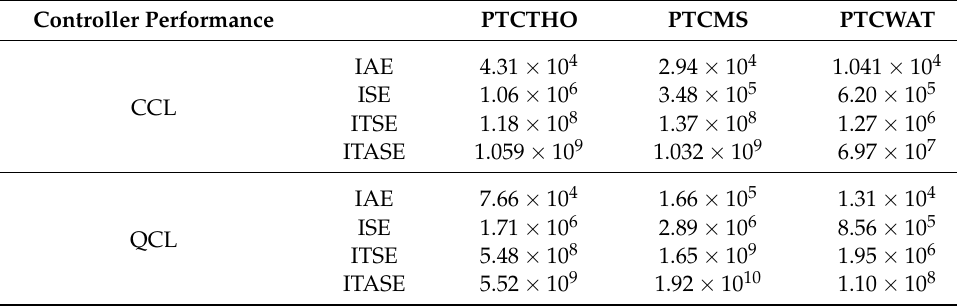
Table 6. PTC Controller performance on case studies.